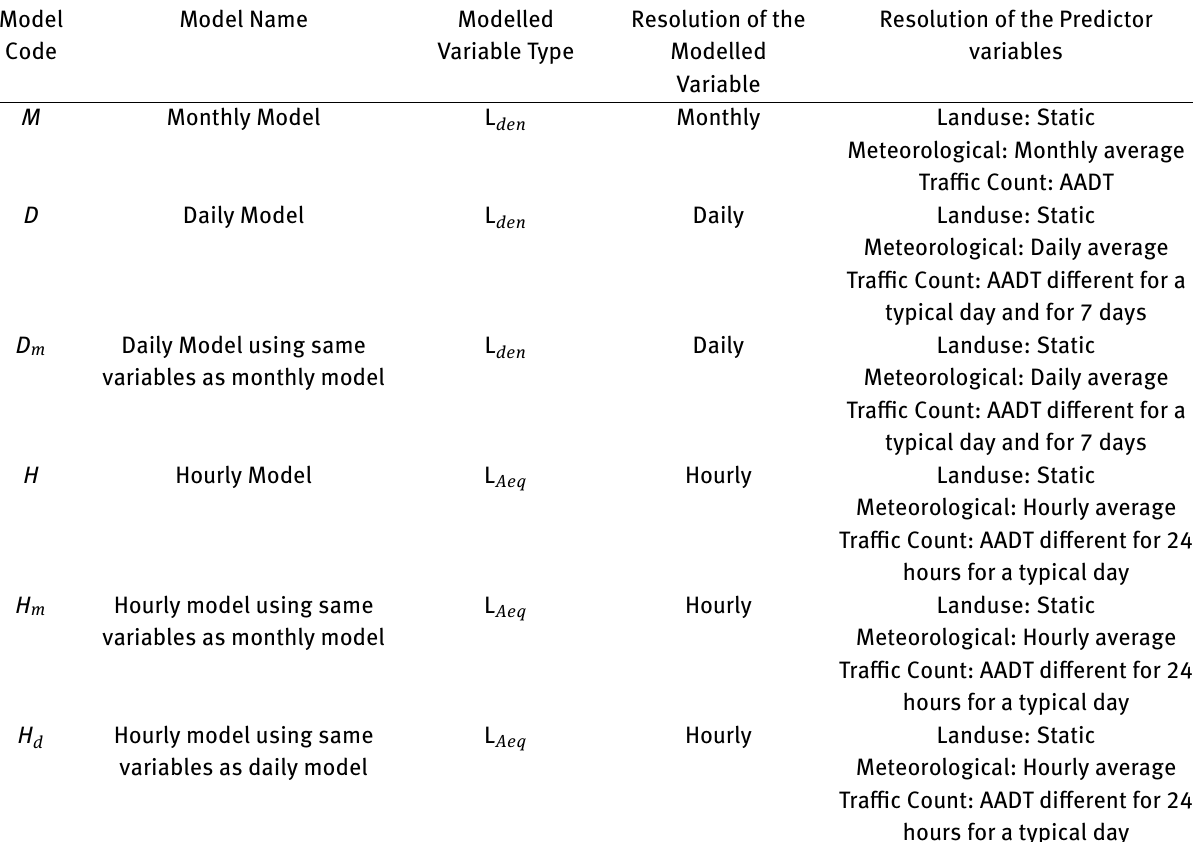
Table 1: Noise models using LUR methodology